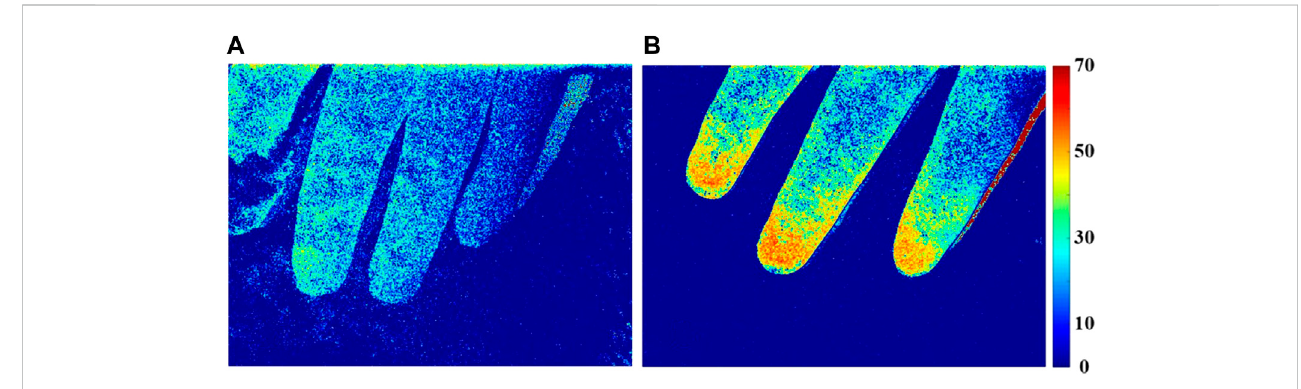
FIGURE 6 Perfusion index (PI) distribution of fi nger microcirculation blood fl ow in patients with septic shock (A) and sepsis (B)